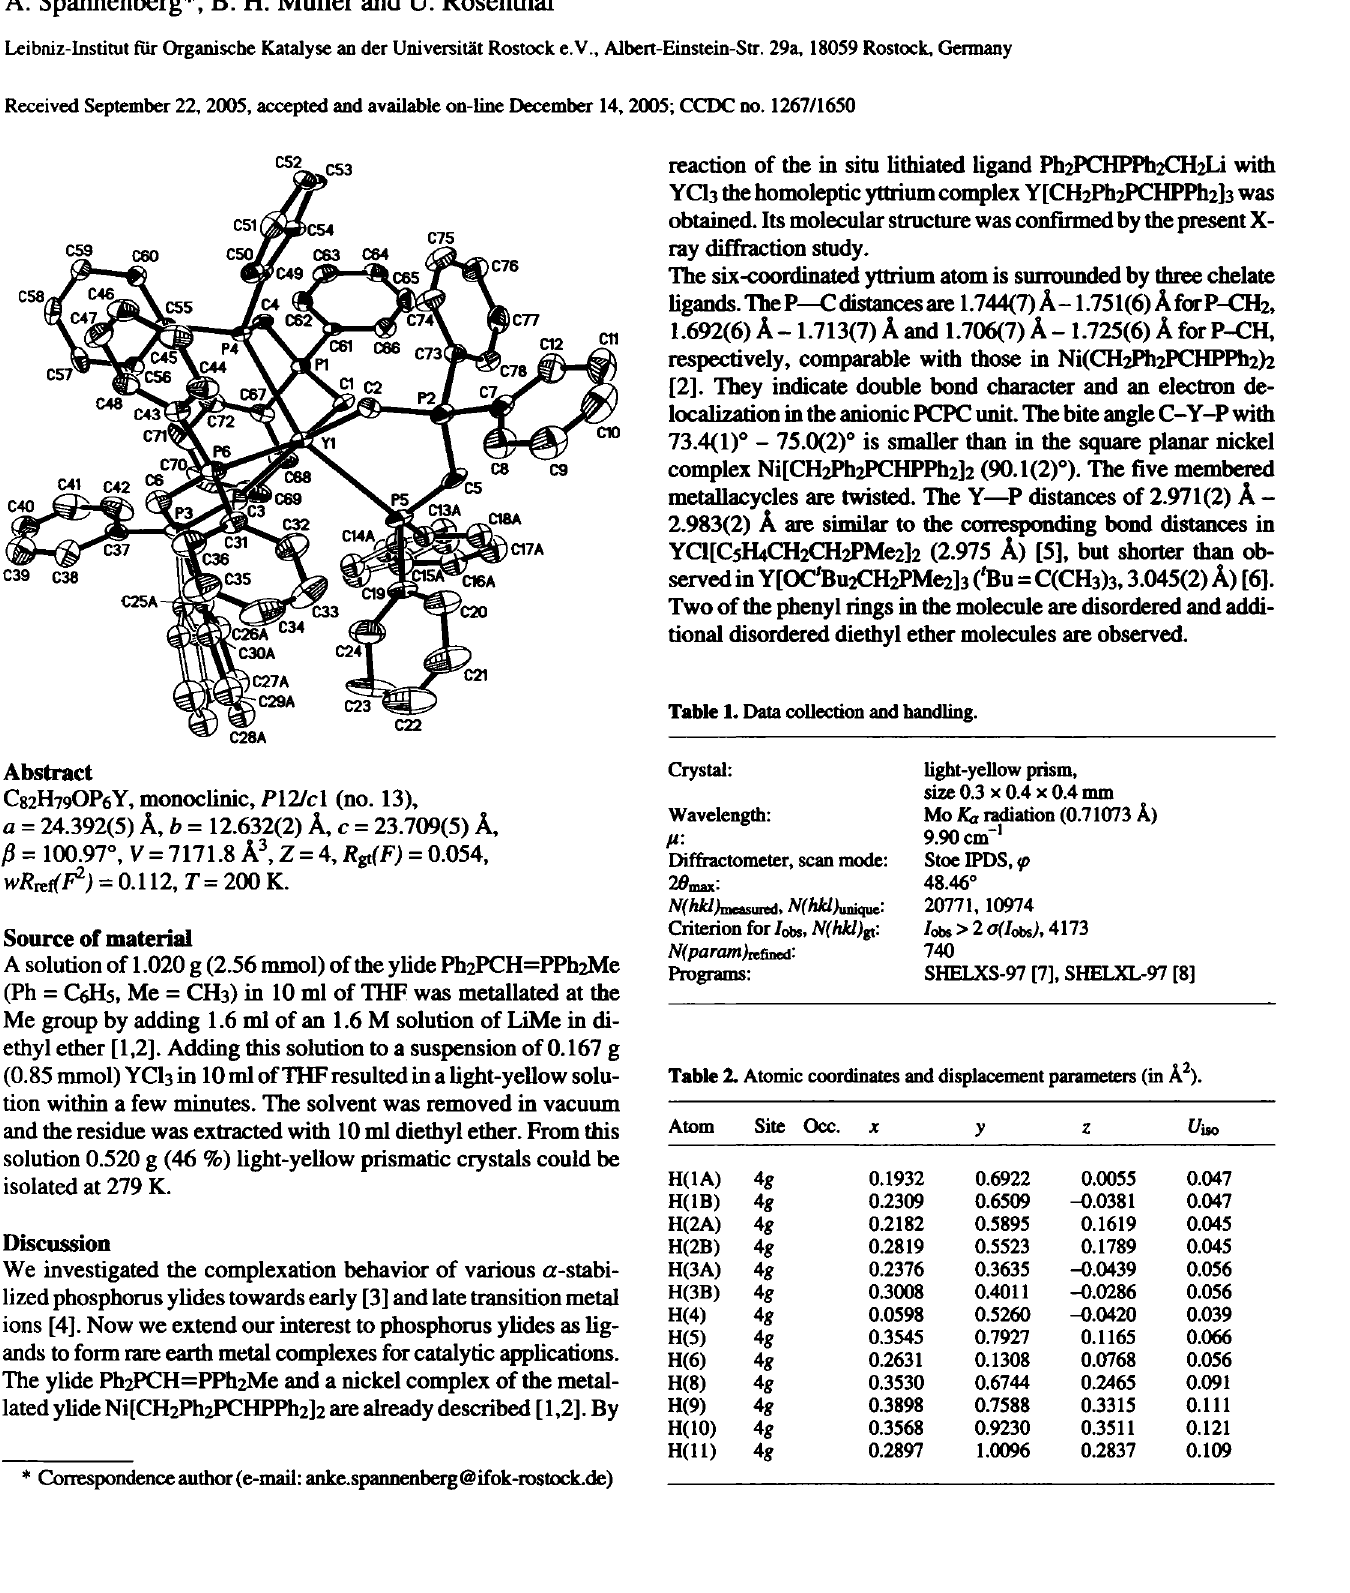
Table 2. Atomic coordinates and displacement parameters (in A 2